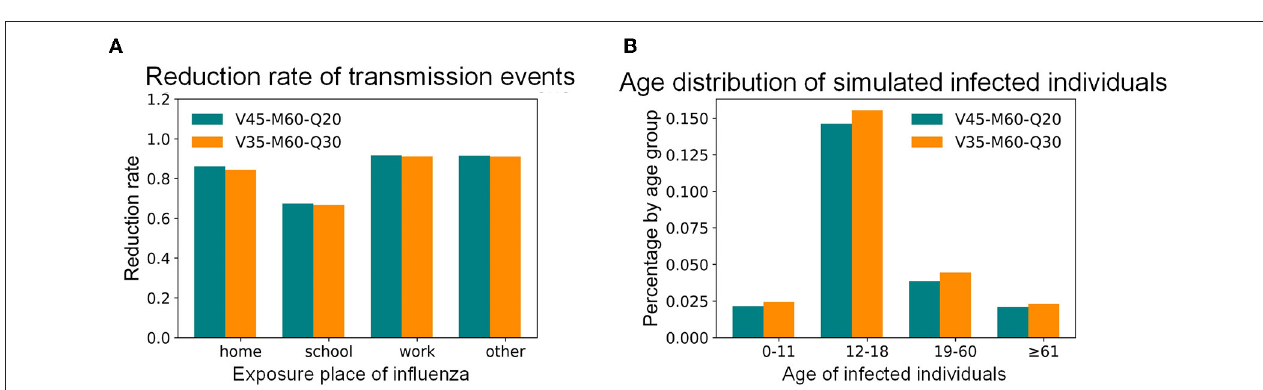
FIGURE 7 | The influenza infection size of Shenzhen under systematical combinations of vaccination rate, mask wearing rate and home-quarantine rate for adults based on the premise that the children and elderly have been fully vaccinated. The green and blue dashed curves are the thresholds of 5% and 15% infection percentage, respectively.